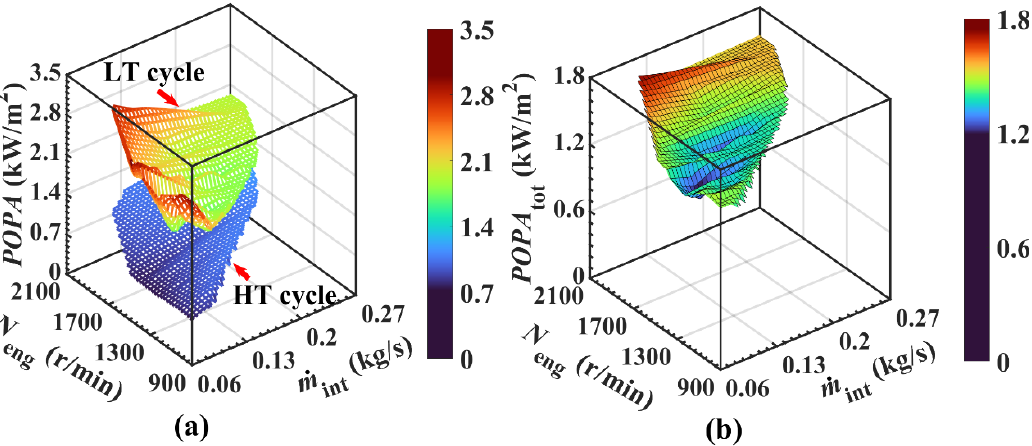
Figure 11. POPA of HT cycle, LT cycle and system under variable working conditions. (a) POPA characteristics analysis of different cycles. (b) POPA characteristic analysis of the system.